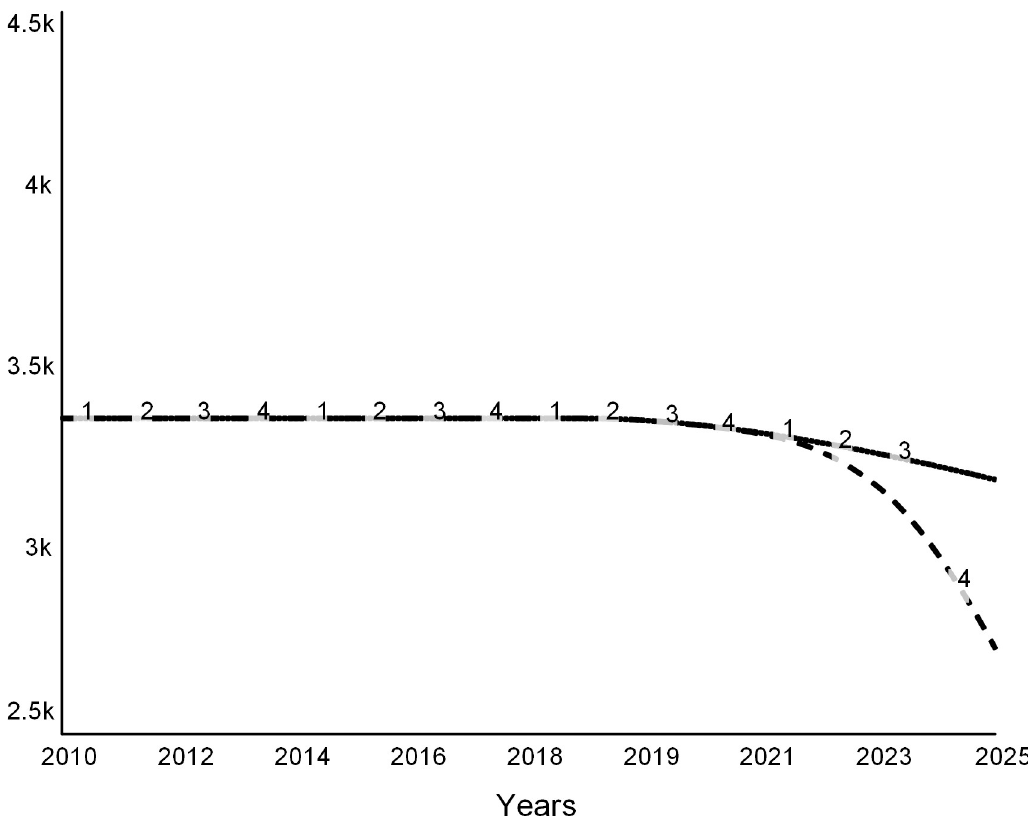
Fig 15. Student enrollments. Curve 1 is the base run: all searchers are allowed. Curve 2: 75% of searches allowed. Curve 3: 50% of searches allowed, and Curve 4: 25% of searches allowed.